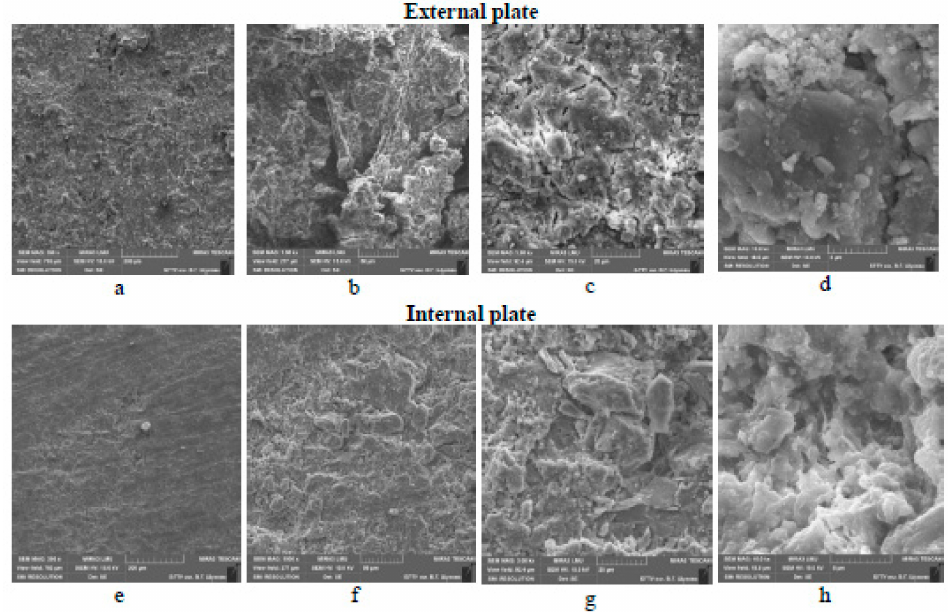
Figure 1. SEM images illustrating the impact of corrosive acids on concrete exposed to chicken coop [6]. ( a ) shows the virgin external plate before acid attack while the micrographs labeled ( b – h ) show the progression of the acid attack and the changes on the surface and cross-sectional